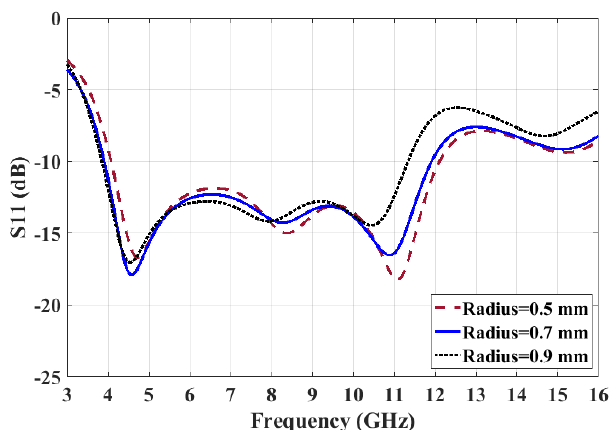
FIGURE 8 . Simulated S-parameters for effect of diameter of shorting pins in the full